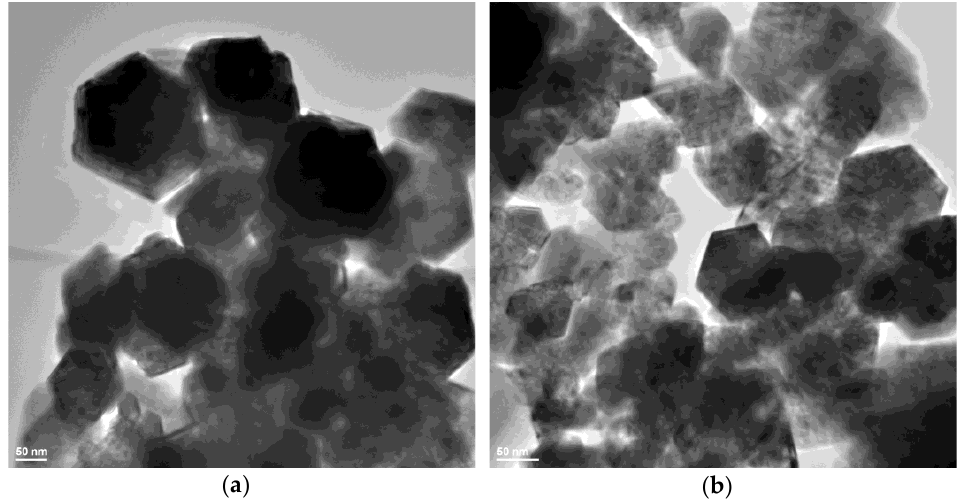
Figure 4. The TEM images for ZnO_EG samples ( a ) 29,500× magnification and SAED pattern of hexagonal ZnO (JCPDS card no. 80-0075) in inset; ( b ) 49,000× magnification; ( c ) 75,000× magnification; ( d ) high resolution TEM with (0 0 2) crystallographic planes.